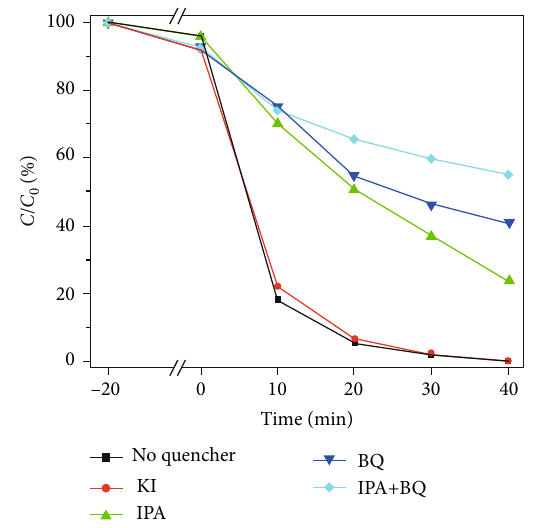
Figure 7: E ff ect of di ff erent scavengers on the degradation of Rh B by the TiO /PdO 2